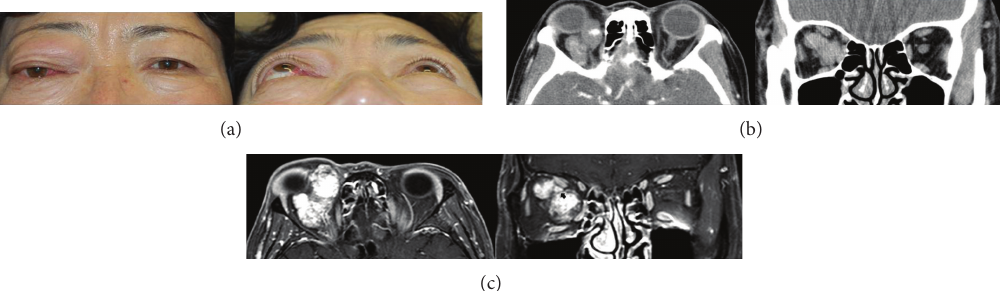
Figure 1: (a) Preoperative clinical photography shows the significant proptosis and inferolateral displacement of right eye. (b) CT scan of initialpresentationshowswell-demarcatedenhancingintraconalvasculartumorintherightorbit.(c)14yearslater,MRIshowinghypointense massesonT1-weightedsequenceandhyperintenseonT2-weightedsequenceanddemonstratingdensecontrastenhancement.Theopticnerve is surrounded and compressed by tumor (black arrow).